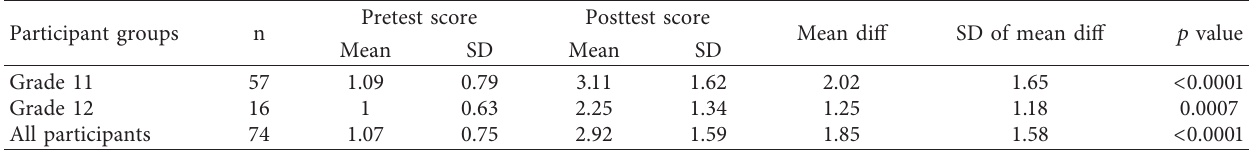
Table 3: Participant group scores before and after STI presentation.